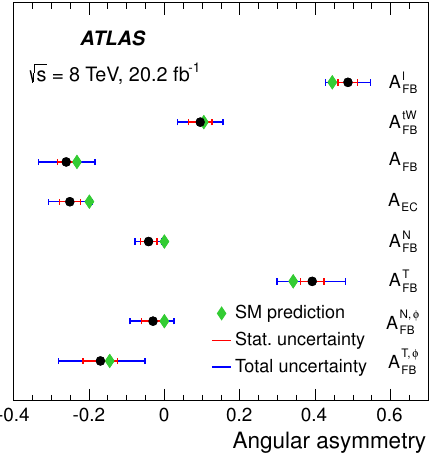
Figure 9. Summary of the measured asymmetries and comparison with the Standard Model predictions.